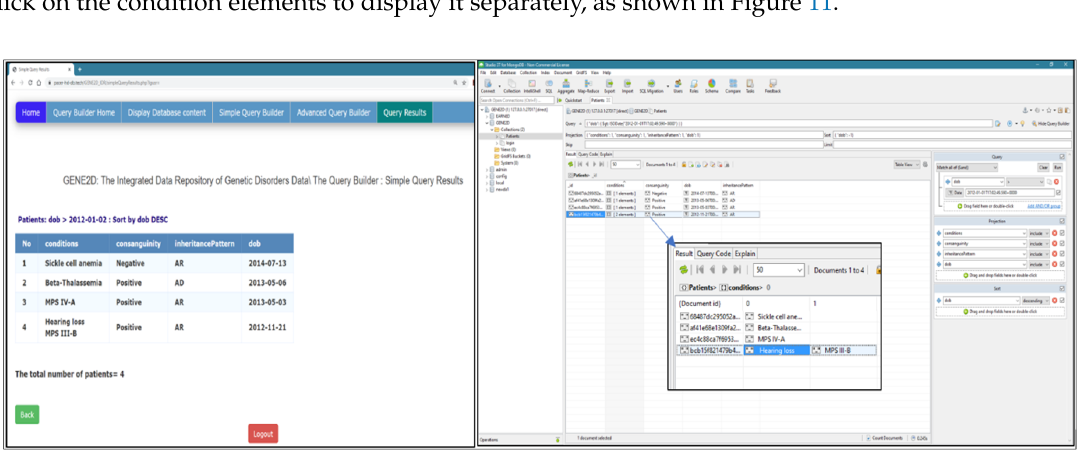
Figure 11. Testing query of date type field.